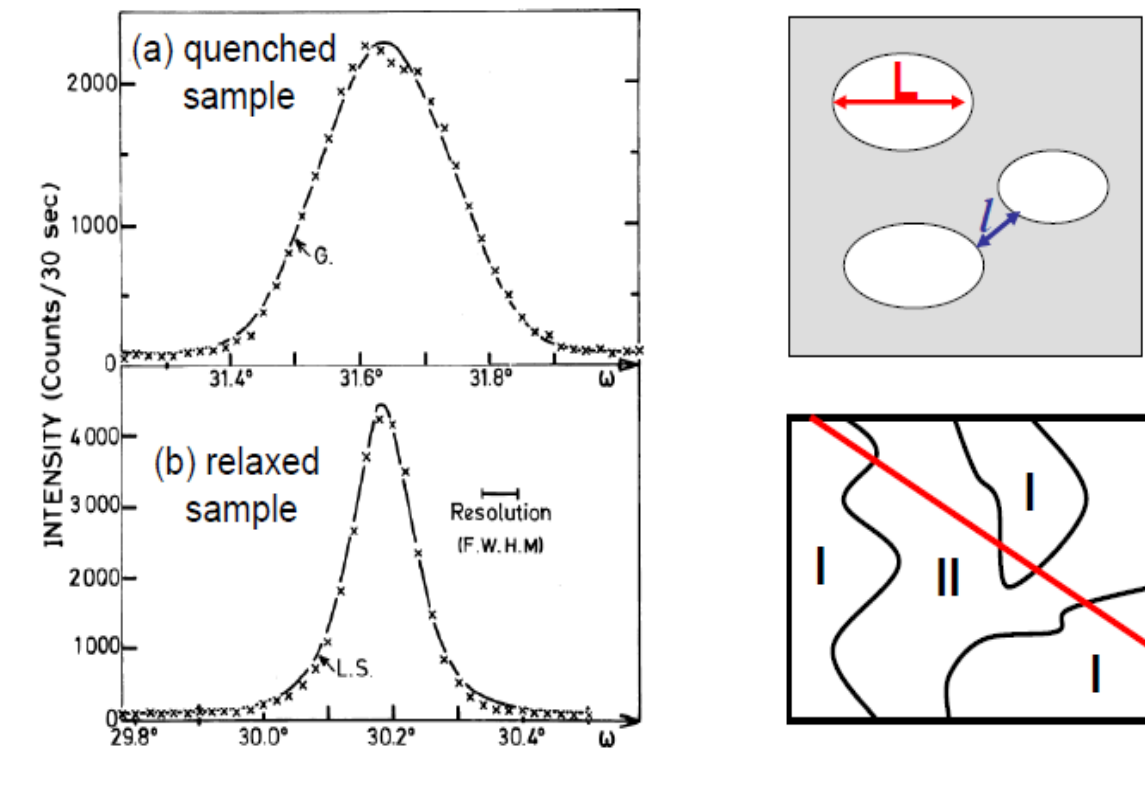
Figure 13. Left part : profile of the same AO superstructure reflection of (TMTSF) in the ( a ) quenched and ( b ) relaxed states (data of [164]). Note the angular broadening (larger than the experimental resolution) of the superstructure reflection when the sample is either in the quenched or in the relaxed state. Right part : texture corresponding to the ( a ) quenched and ( b ) relaxed states. In (a) L is the typical size of a domain of ordered ClO a typical inter-domain distance and the grey background represents non ordered ClO (b) domains of types I and II with opposite ClO drawn in (b) there is a large distribution of domain